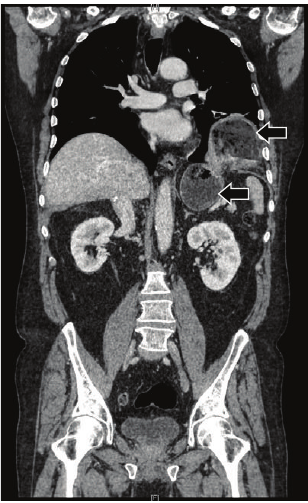
Figure 2: Abdominal CT scan (both arrows point at gastric content, the highest one into the thorax).